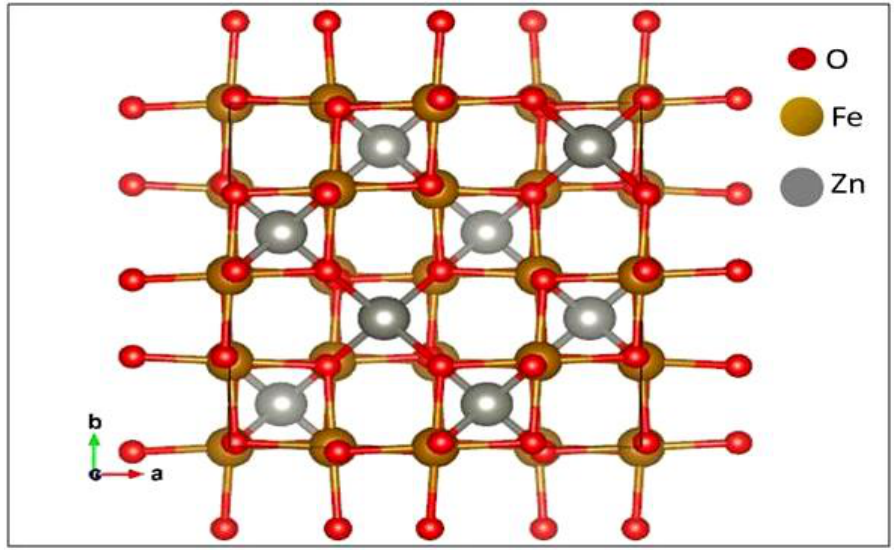
Figure 2. Crystalized in a cubic unit cell of ZnFe 2 O 4 NPs. Table 1. Refined unit cells parameters of ZnFe 2 O 4 nanoparticles.